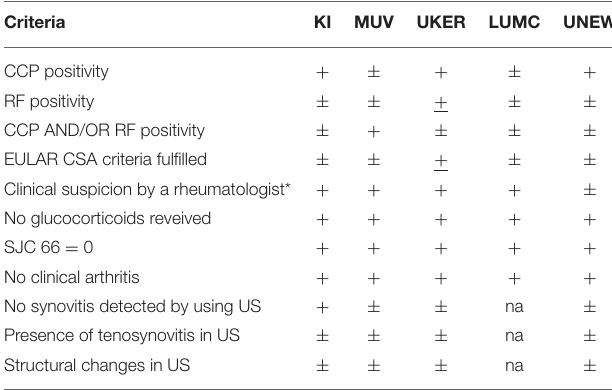
TABLE 2 | Criteria necessary for inclusion into the individual at-risk cohort programs.